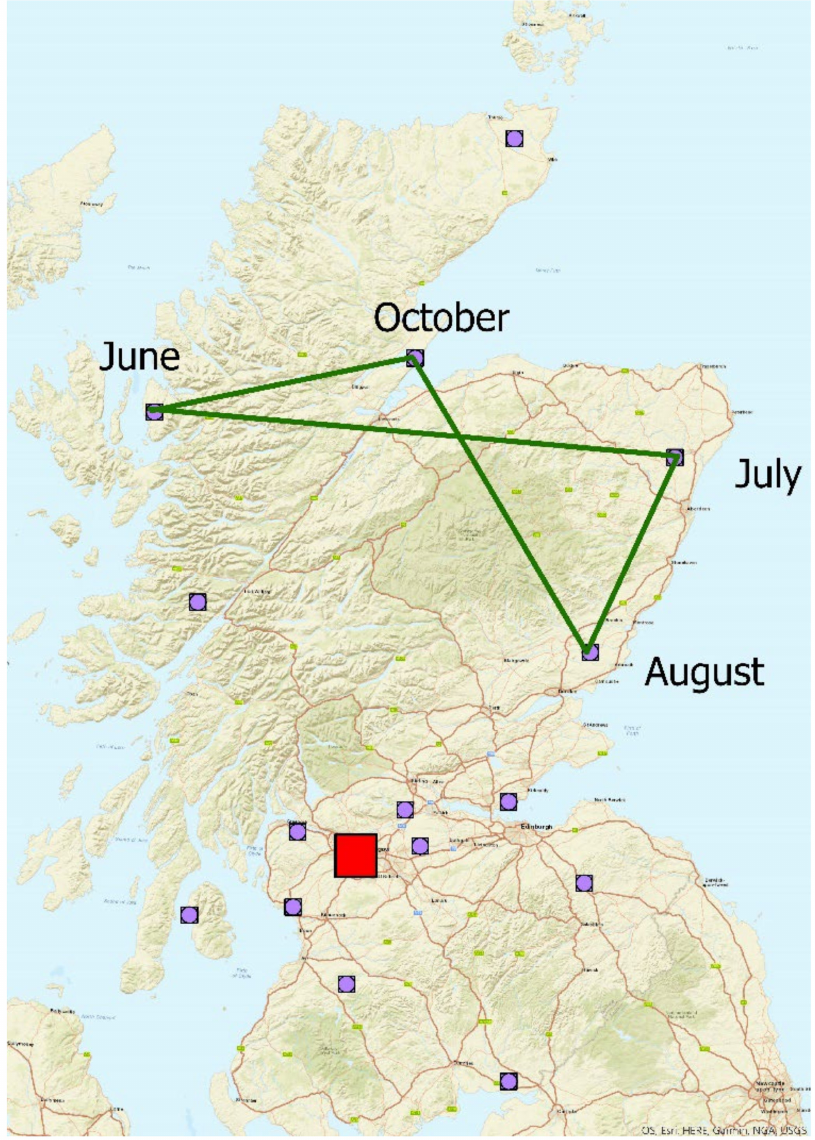
Figure 7. Biomass supply chain setup and MFP routing (BC scenario). The purple nodes depict the node centers of each group of marginal fields. The red square depicts the establishment of an FFP and FU facility. The green line illustrates the routing of the MFP unit in monthly